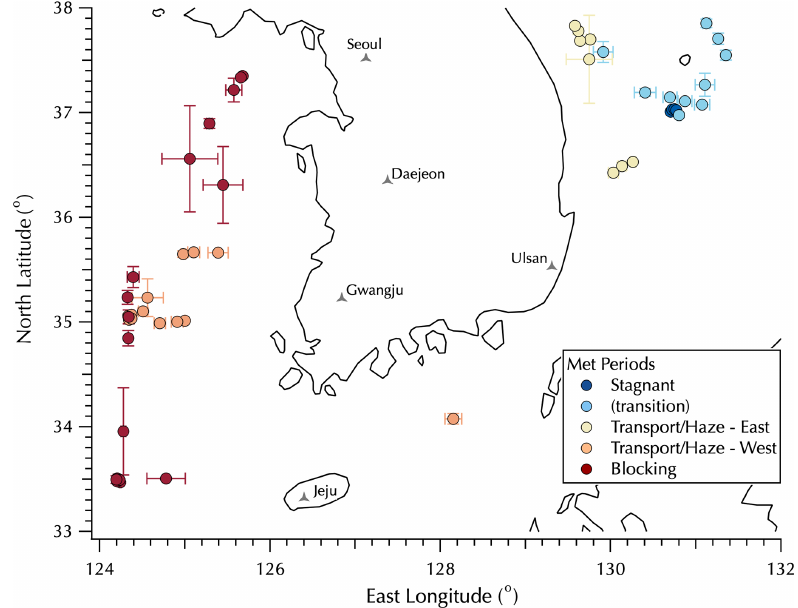
Figure 1. Map of mean sampling locations for the filter data set colored by the Peterson et al. (2019) meteorological regimes with Trans- port/Haze data split between upwind (west, orange) and downwind (east, yellow) positions around the peninsula. Error bars represent 1 SD of the mean filter sample latitude and longitude, used to distinguish filters collected on station from those collected underway. See Table S1 for